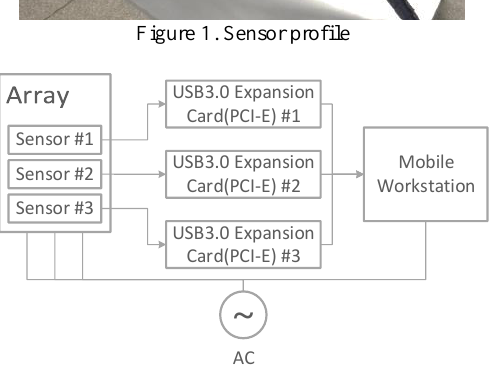
Figure 2. System connection